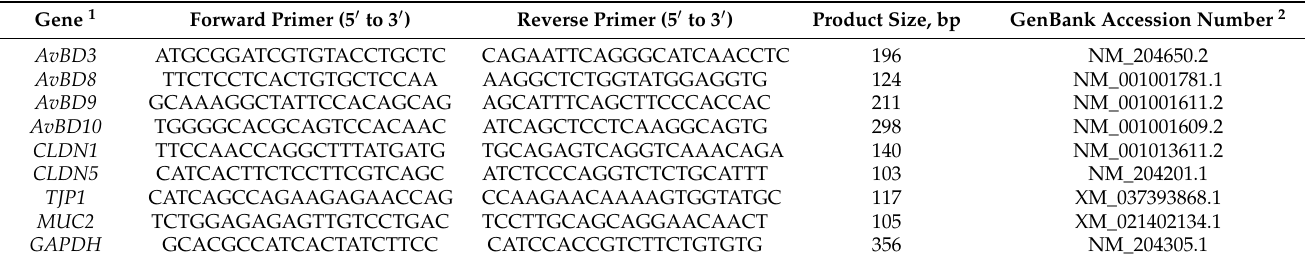
Table 2. Sequences of primers used in